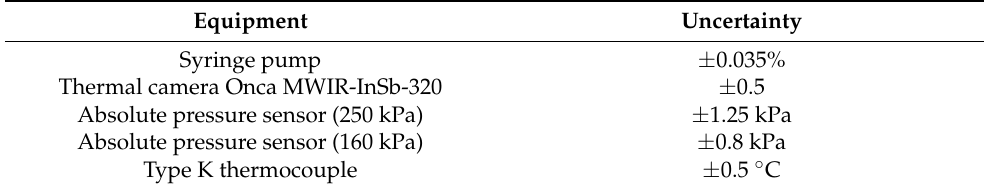
Table 1. Main uncertainties associated with the equipment used in this work.